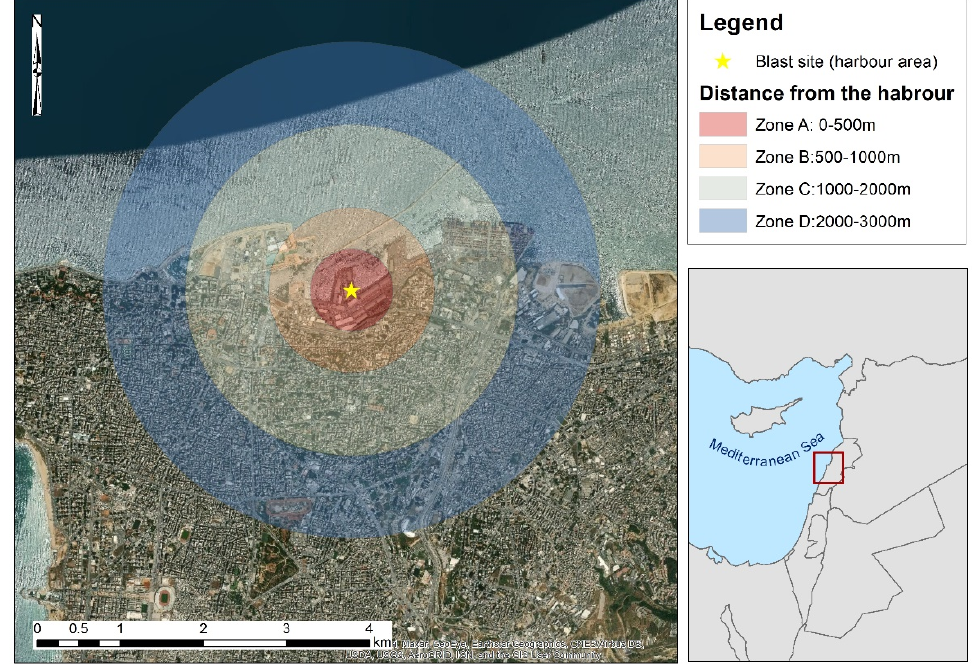
Figure 2. Study area indicating the harbor area (blast site) with a yellow star and the various zones created for further consideration covering distances from 0 to 3000 m away from the blast site.